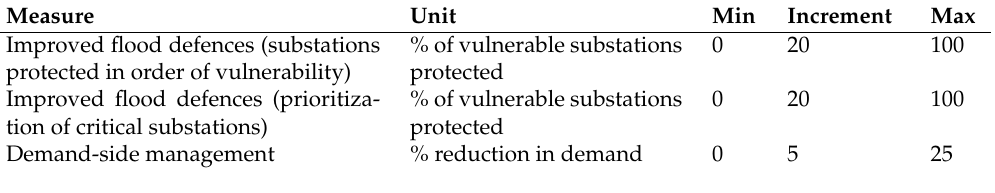
Table 2. Summary of adaptation measures tested in the developed